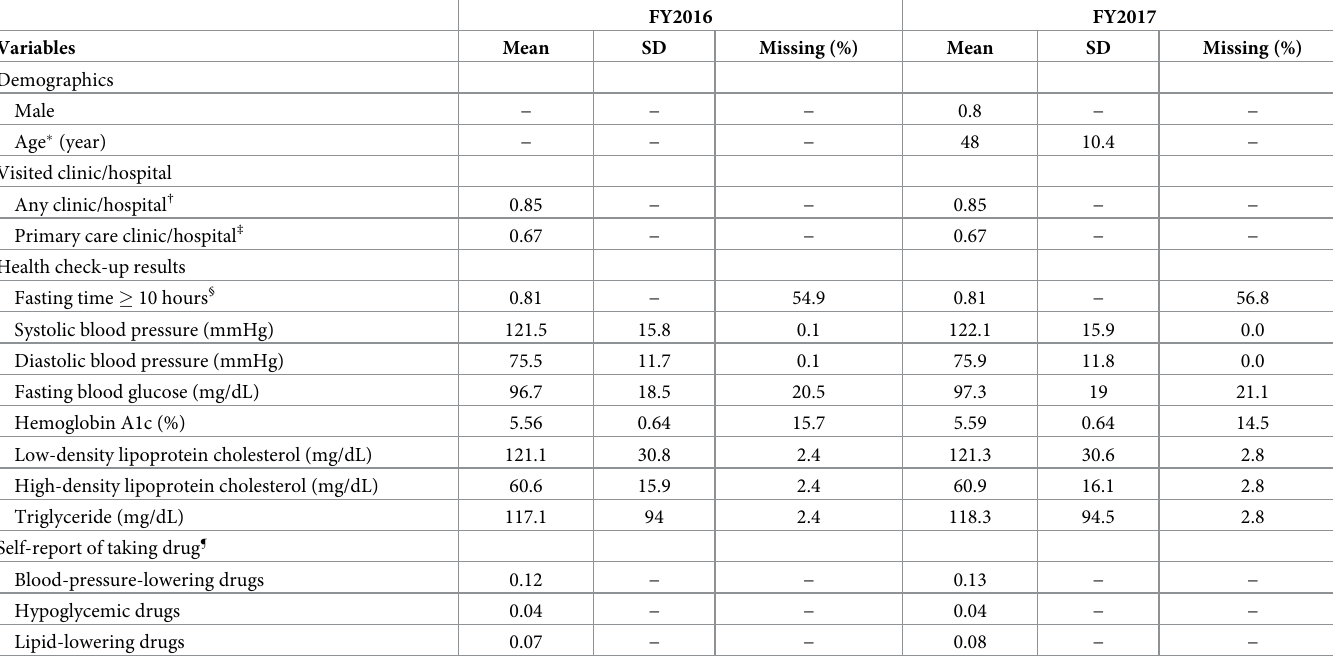
Table 2. Summary statistics of enrollees’ characteristics and health check-up results for each fiscal year of the enrollees with complete data on the self-reported use of blood pressure- and lipid-lowering drugs and hypoglycemic drugs (N = 944,717).